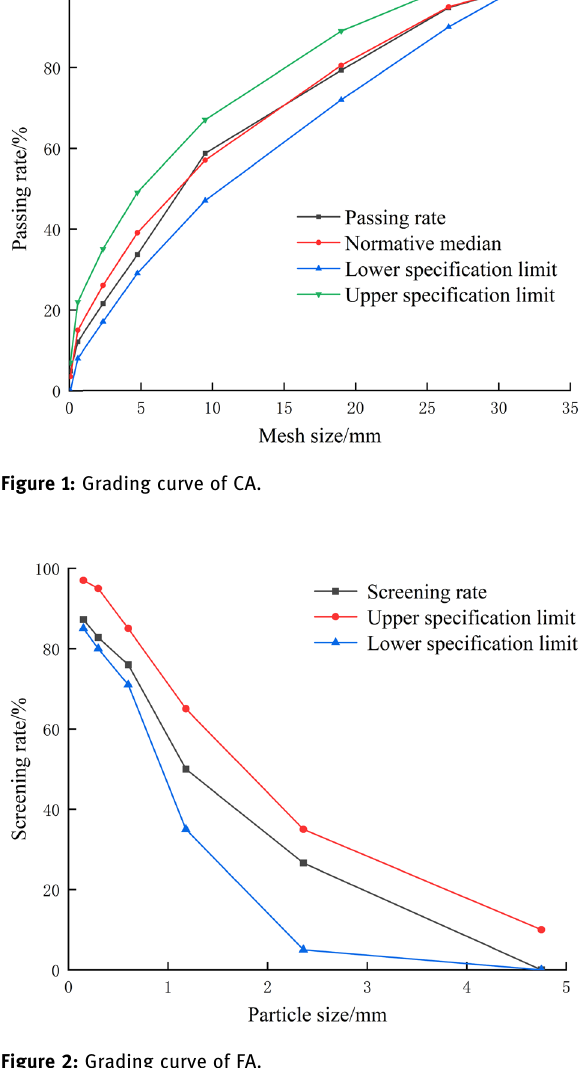
Table 4: Properties of fl y